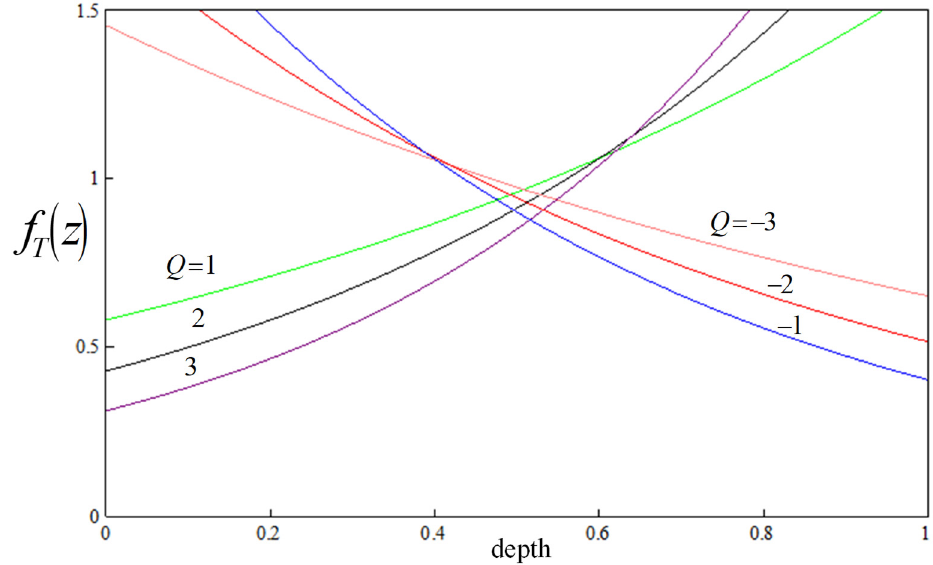
( ) Figure 2. Plot of f T ( z ) with depth for different values of Q with Le = 0.5, Rs = 10, Da = 0.1, Figure 2. Plot of T f z with depth for different values of ξ = 0.5, η = 0.5, and δ = 0.5, 0.5, ξ η= = and 0.5. δ=